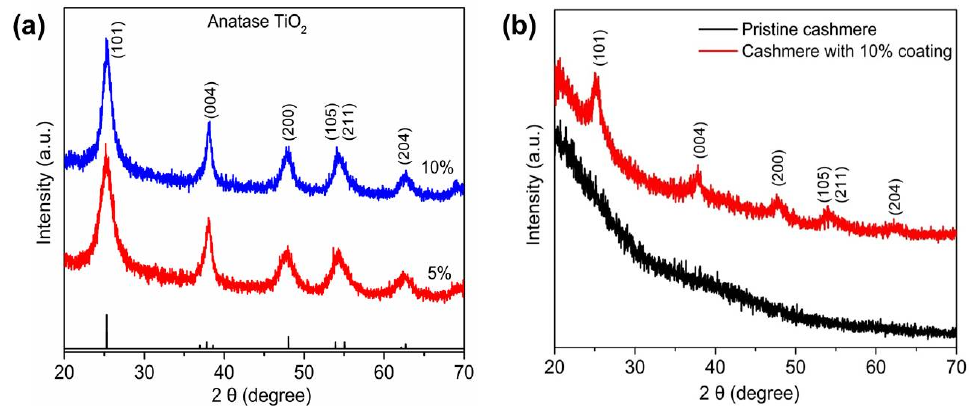
Figure 1. XRD spectra of ( a ) solid extracts from 5% and 10% TiO 2 colloids, ( b ) cashmere fabric with 10% coating and pristine cashmere fabric.